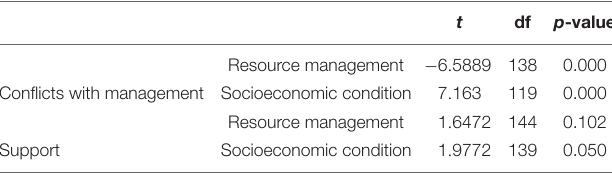
TABLE 8 | T -test results show whether there is any difference in the opinion regarding existing resource management practice and socioeconomic condition between fishers those received support or not and having conflict with management or not based on fishers’ survey.